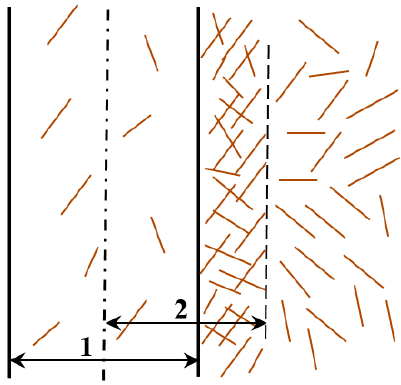
Figure 4. Measurement of the distance plant residue was removed: 1—Strip with removed plant residue; 2—distance measurement.